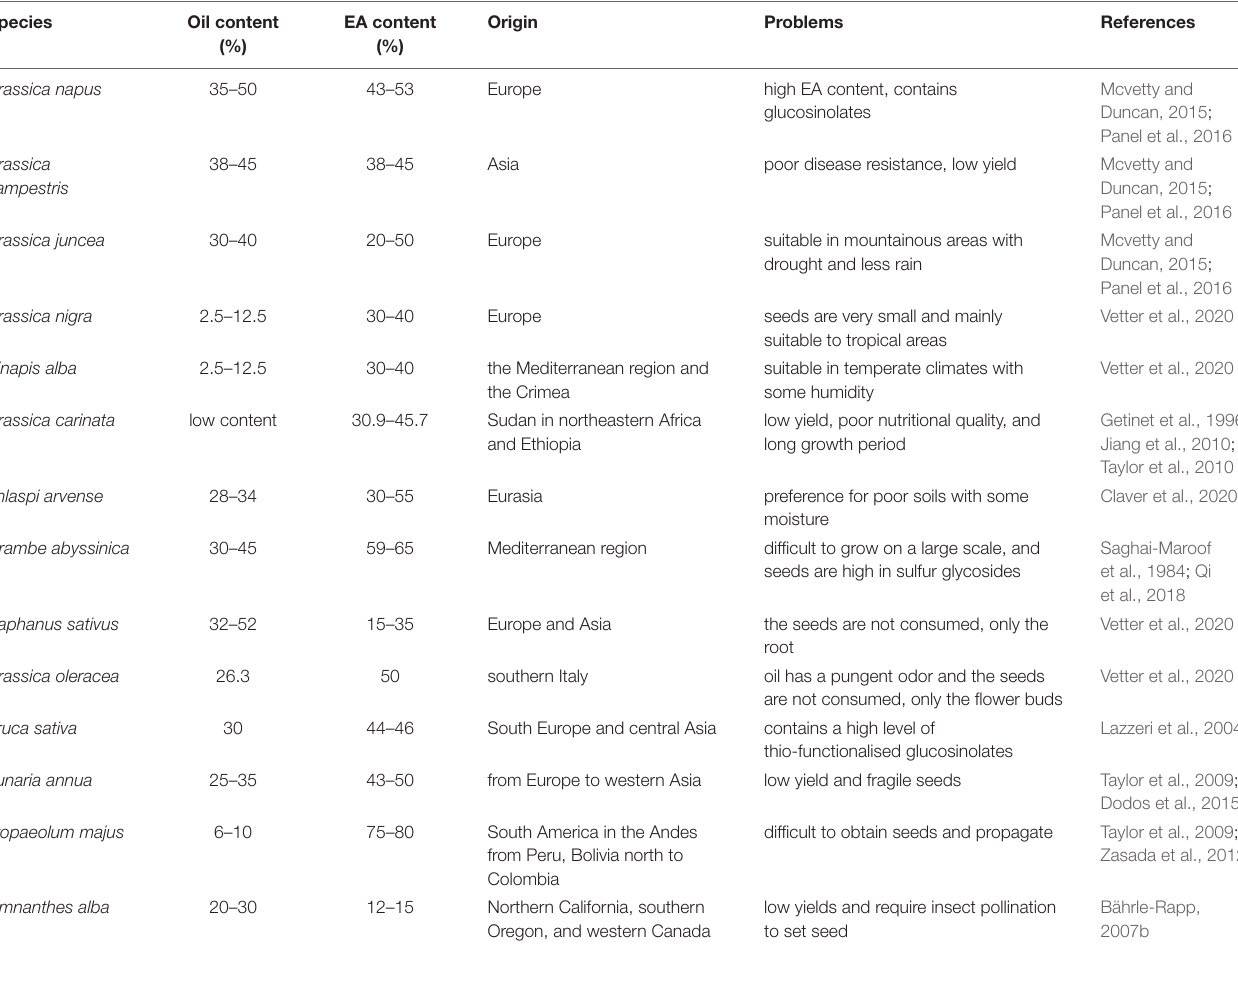
TABLE 1 | Summary of the information including seed oil content, EA content and EA production limitations on the main plant seeds rich in EA.